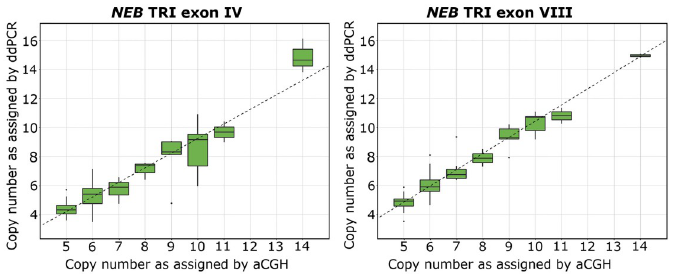
Fig 2. Boxplots visualizing the CN of the NEB TRI exon IV and VIII assays in relation to the CN assigned by aCGH with linear regression trend line. The NEB TRI exon IV assay gives a relationship with a lower linear slope than the NEB TRI exon VIII assay, which seems to follow a 1:1 linear relationship adequately. The dashed lines represent the linear regression trend lines.